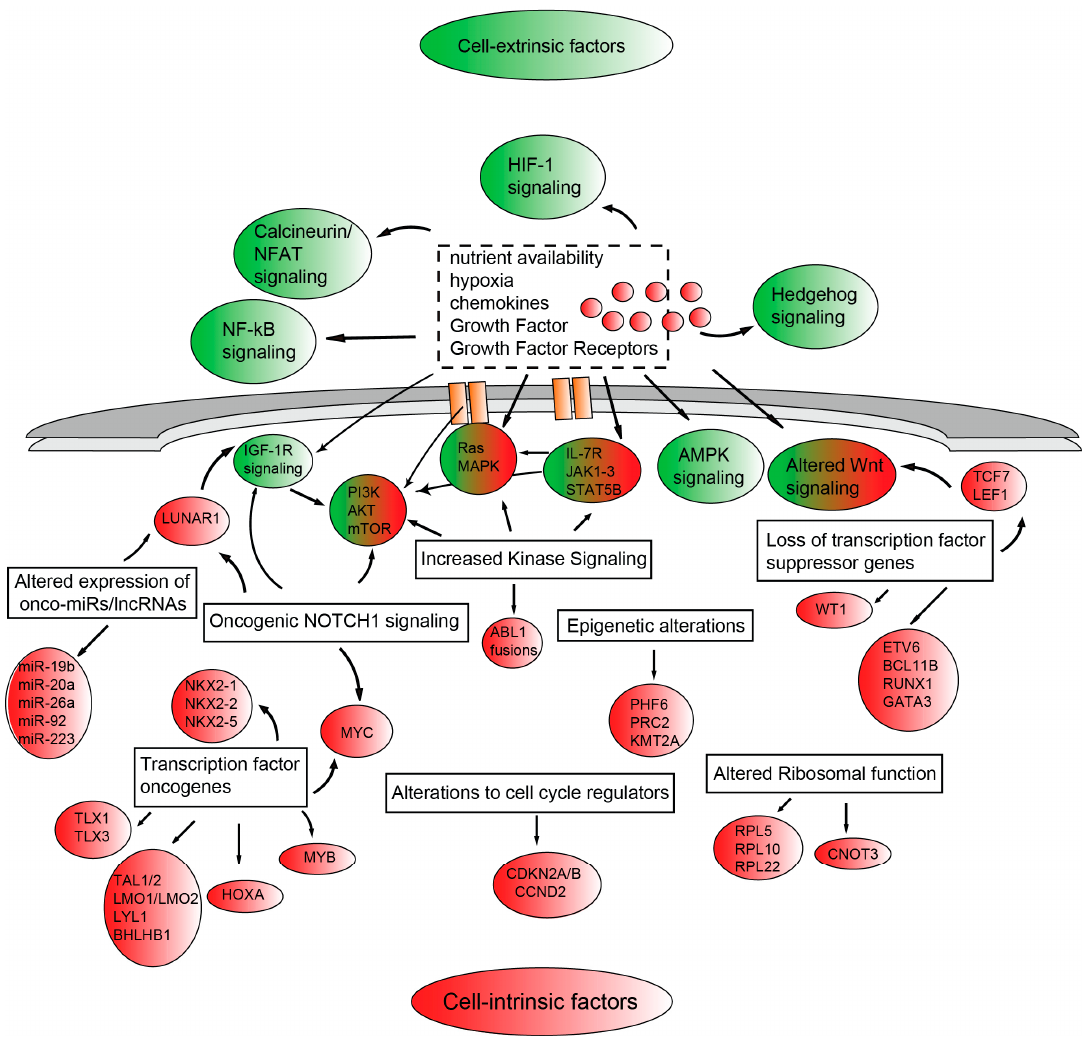
Figure 1. Schematic representation of signaling pathways aberrantly activated in T-cell acute lymphoblastic leukemia (T-ALL), tentatively subdivided as being mainly due to cell-extrinsic (shaded green) and cell-intrinsic factors (shaded red) or mixed (green and red).